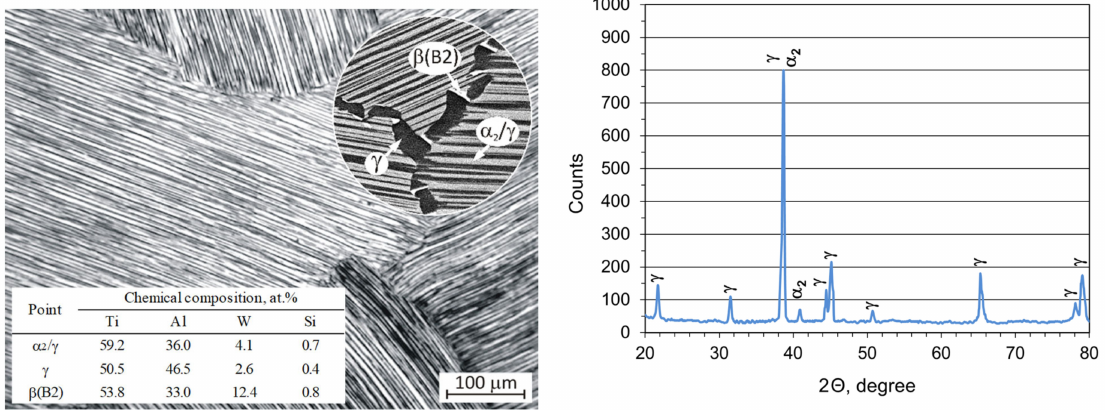
Figure 2. Microstructure and X-ray diffraction patterns of Ti-47Al-2W-0.5Si